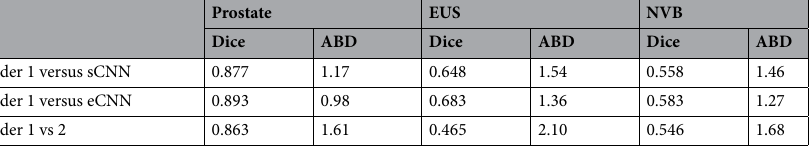
Table 1. Comparison of segmentation results on BWH test data of the automatic single (sCNN) and ensemble CNN (eCNN) prediction against manual segmentation by Reader 1. Manual segmentation by Reader 2 is also compared against Reader 1. ABD is given in millimeter (mm).